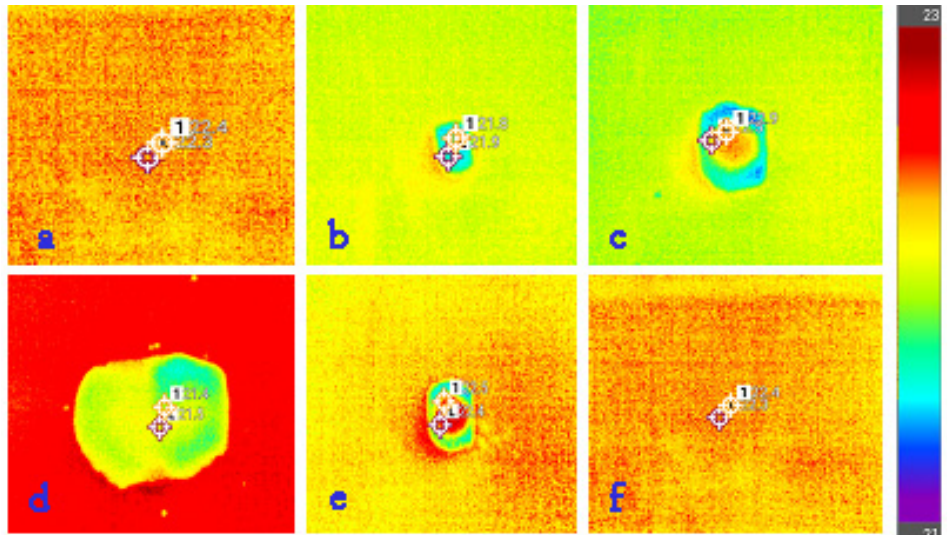
Figure 3. Thermographic images taken in different fluid transport phases: ( a ) material was placed; ( b ) distilled water was dispensed; ( c ) the size of the wetted zone increased; ( d ) the size of the wetted zone increased to its maximum; ( e ) the wetted area shrank; ( f ) the end of the active drying phase.